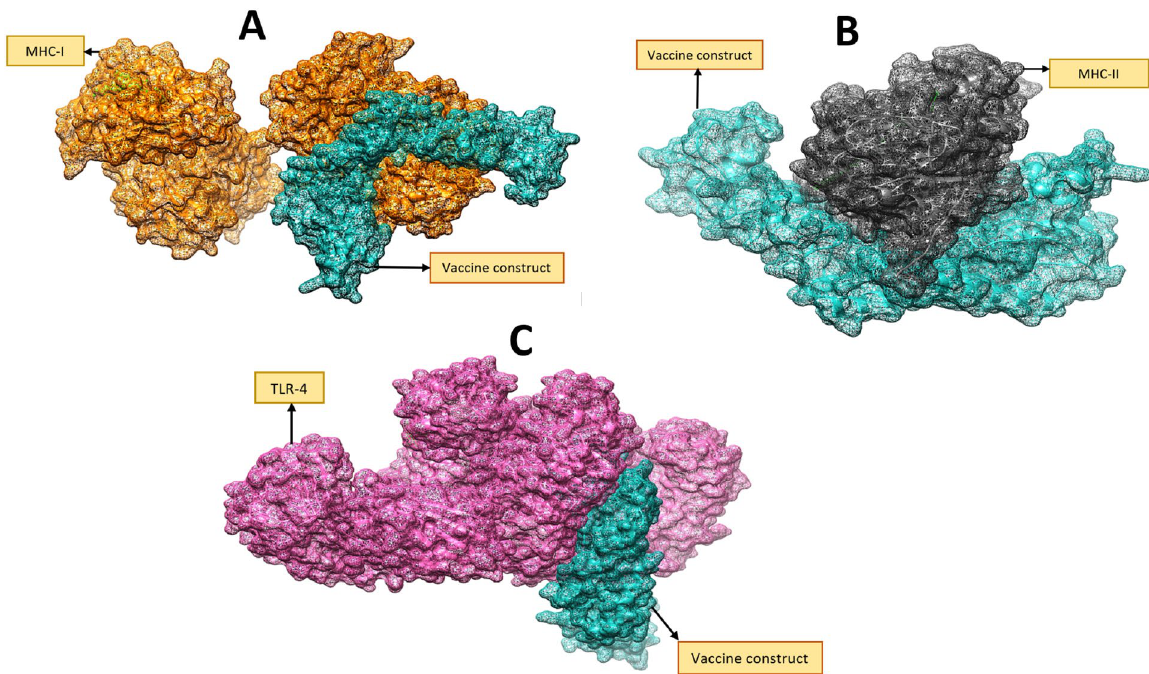
Figure 8. Illustration of interaction with MHC-I ( A ), MHC-II ( B ) and TLR-4 ( C ) with the